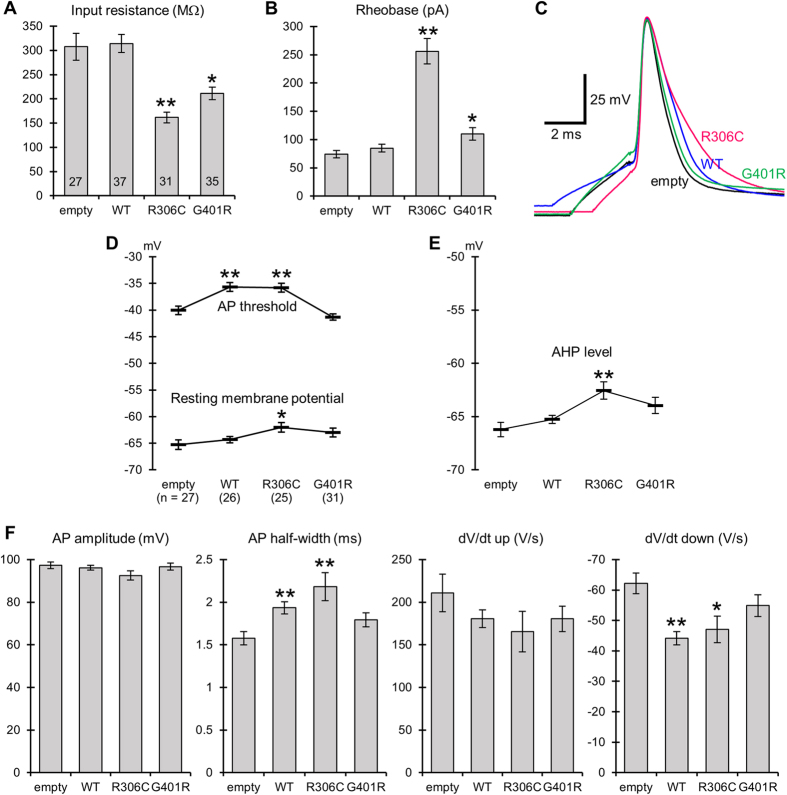
Passive membrane properties and characteristics of a single action potential spike evoked by a short 2–5 ms current pulse in Kv2.1 mutant-transfected primary cortical neurons.(A) Comparison of input resistance under resting conditions. *P < 0.05 compared with empty and R306C, and P < 0.01 compared with WT. **P < 0.01 compared with empty and WT, and P < 0.05 compared with G401R by Dunnett’s T3 test. (B) Comparison of rheobase. *P < 0.05 compared with empty, and P < 0.01 compared with R306C. **P < 0.01 compared with empty, WT, and G401R by Dunnett’s T3 test. The numbers of cells analyzed in (A,B) are indicated in the bars in (A). (C) Representative traces of single APs evoked by 2–5 ms current injections. Duration of current injection was adjusted, therefore injected currents did not affect spike upstrokes. Spike upstrokes were superimposed to highlight differences in speed of spike repolarization. (D) Resting membrane potentials and voltage thresholds for spike generation (AP threshold). *P < 0.05 compared with resting membrane potential in empty by REGW F test. **P < 0.01 compared with AP thresholds in empty and G401R by REGW F test. (E) Minimum voltage level of afterhyperpolarization (AHP level). **P < 0.01 compared with AHP level in empty, and P < 0.05 compared with WT by Dunnett’s T3 test. (F) Amplitude (AP amplitude), half-width (AP half-width), speed of spike upstrokes (dV/dt up) and downstrokes (dV/dt down) for a single action potential. *P < 0.05, **P < 0.01 compared with empty by Dunnett’s T3 test. There were no statistical differences in these spike parameters between WT and R306C. The number of cells analysed in (D–F) are indicated in the parentheses in (D).